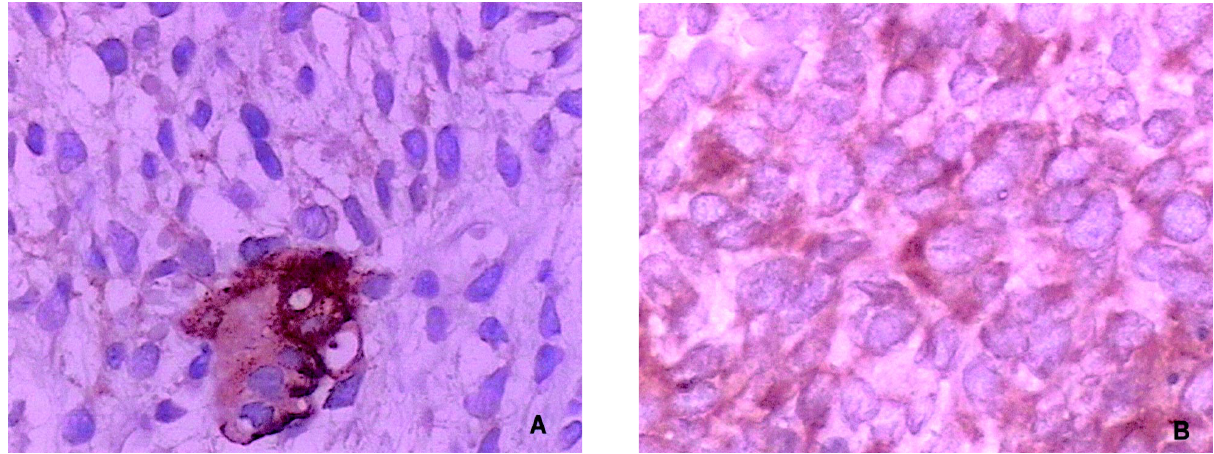
Figure 4 – Immunohistochemical study. A) - Immunoreactivity of the monophasic fibrous component to epithelial membrane antigen around imprisoned renal tubule. B) - Positivity of the poorly differentiated component to Bcl-2 (Immunolabeling,